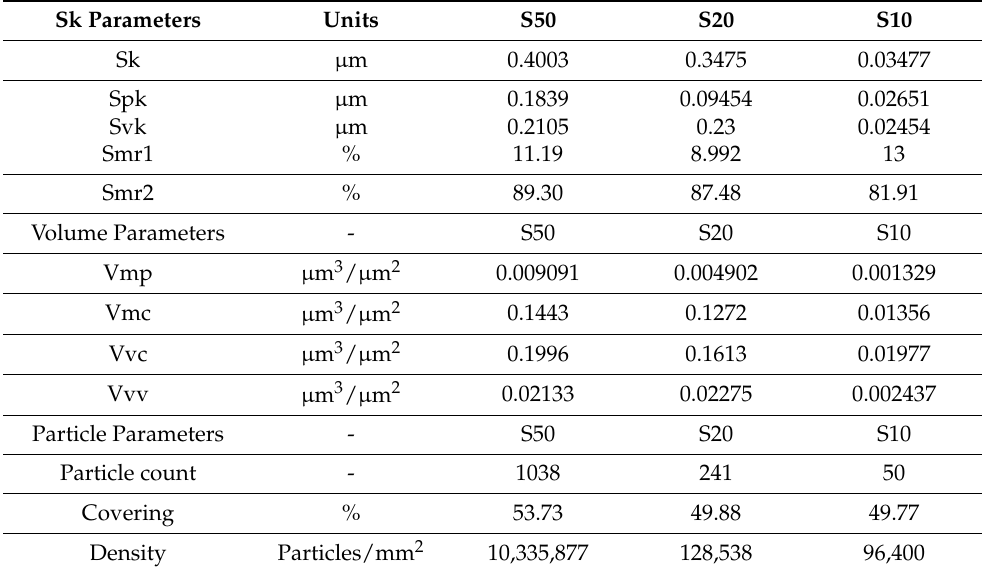
Table 2. ISO and morphological parameters of Andiroba leaf surface for three different size image. Sk